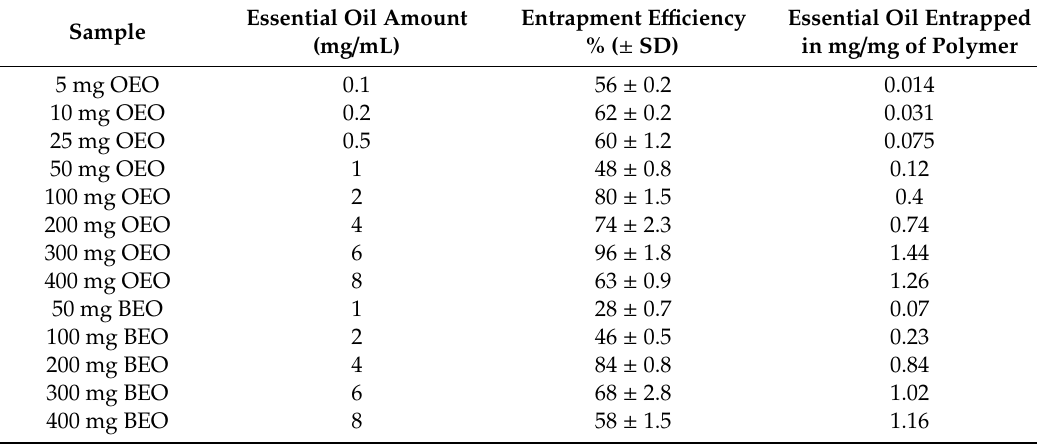
Table 2. Encapsulation e ffi ciency and essential oil entrapment / mg polymer for all nanoparticles (data ± standard deviation). SD = standard